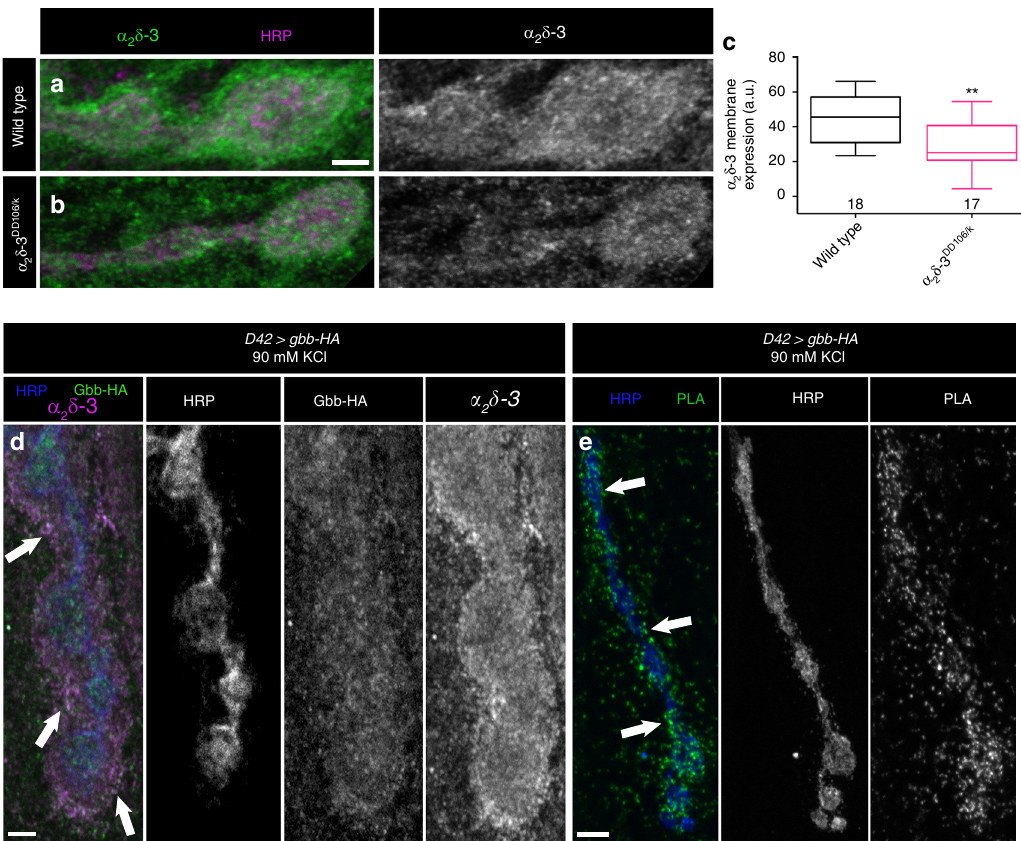
Fig. 9 α 2 δ -3 and presynaptic Gbb are in close proximity. a , b Representative z -projections of boutons of the indicated genotypes labeled with HRP (magenta) and α 2 δ -3 (green). Scale bar: 2 µ m. c Quanti fi cation of α 2 δ -3 membrane expression. n is the number of NMJs scored. ** p < 0.01 by a two-tailed Mann – Whitney test. d Representative z -projections of boutons of the indicated genotype after neuronal stimulation labeled with HRP (blue), α 2 δ -3 (magenta), and Gbb-HA (green). Arrows denote areas of co-localization of presynaptic Gbb and α 2 δ -3. Scale bar: 2 µ m. e Representative z -projection of boutons labeled with HRP (blue) and PLA-speci fi c probes (green) to detect proximity ligation events. Arrows denote close proximity of presynaptic Gbb and α 2 δ -3 as exhibited by expression of PLA-speci fi c probes along the rim of the neuronal membrane. Scale bar: 5 µ